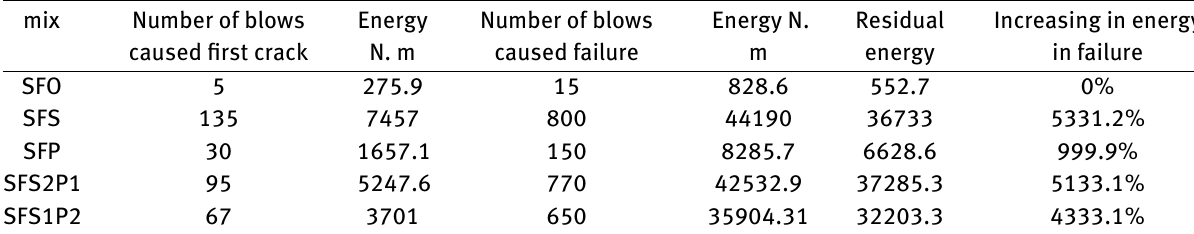
Table 5: The results of impact resistance